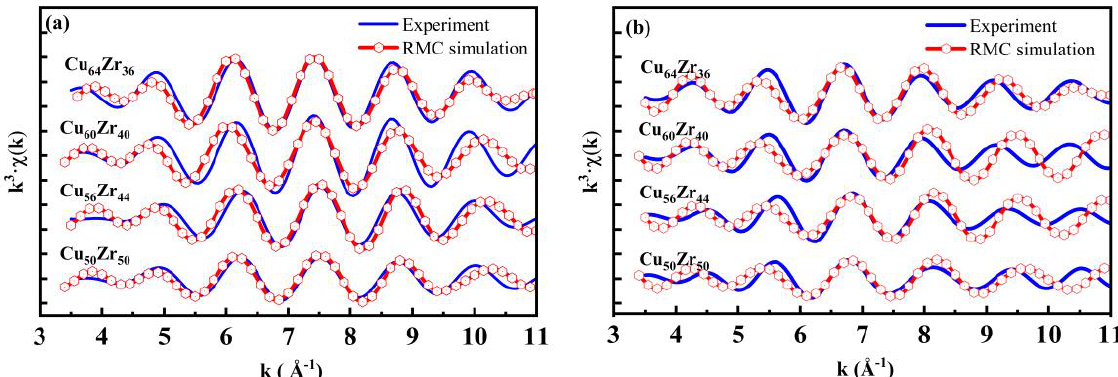
Figure 2. EXAFS k 3 χ(k) spectra of Cu X Zr 100-X (x = 50, 56, 60, 64) MGs obtained by experiments (solid blue line) and FEFF8.5L calculations using the RMC configurations (red dotted line). ( a ) Cu K-edge; ( b ) Zr K-edge.